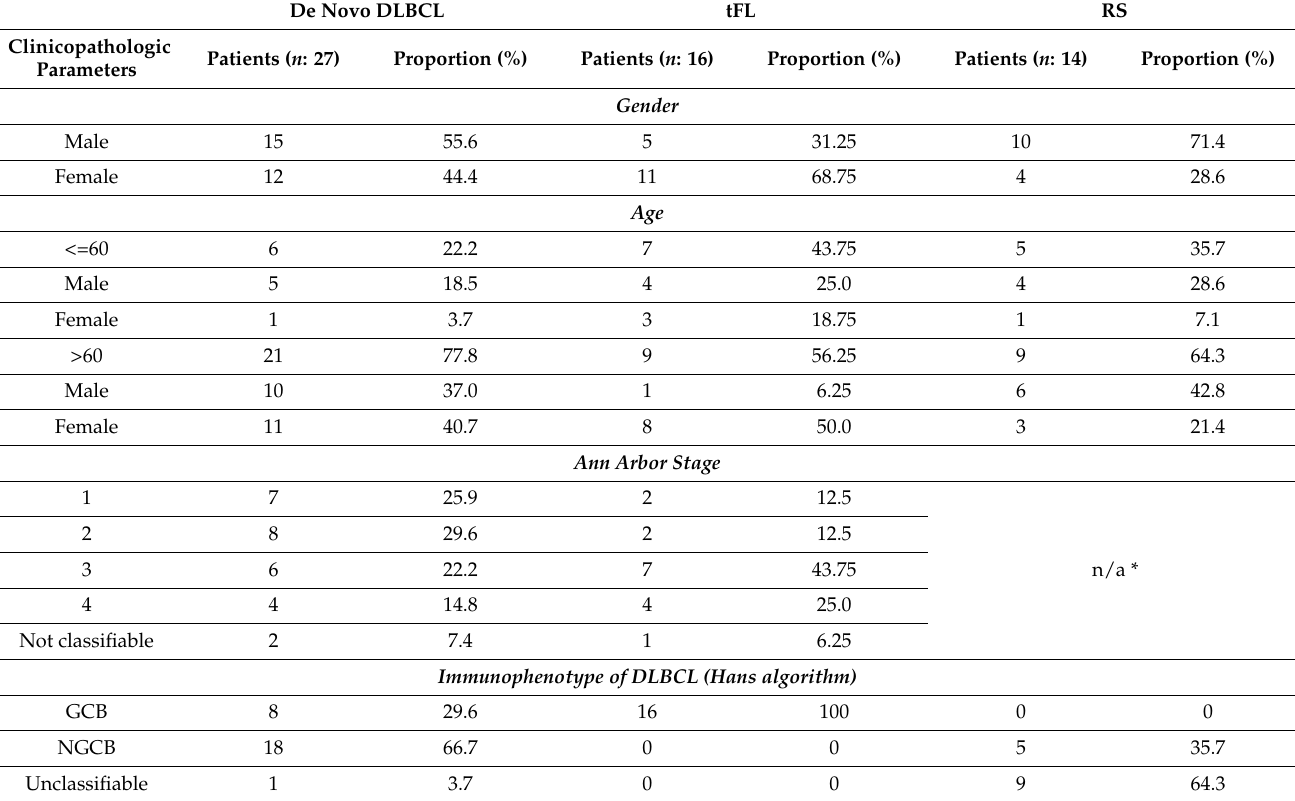
Table 4. Clinicopathologic characteristics of lymphoma patients included in this